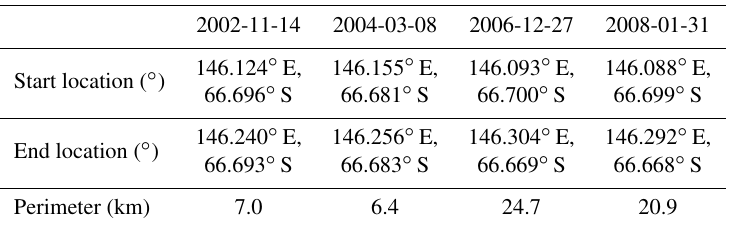
Table 3. Statistics of grounding outlines of the MIT as shown with thick polylines in Fig. 7 from 14 November 2002, 8 March 2004, 27 December 2006 and 31 January 2008,